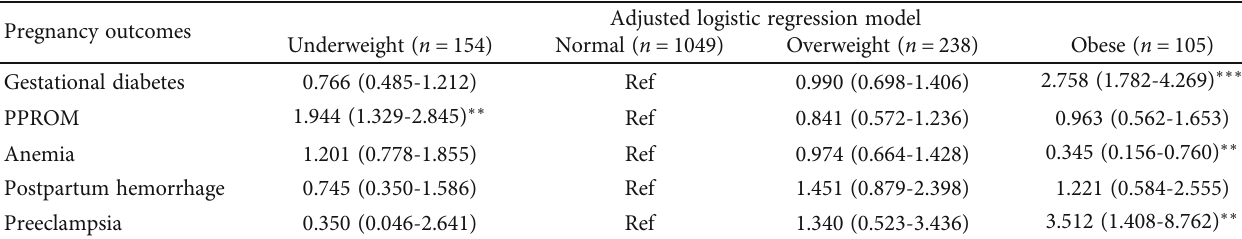
Table 3: The association between prepregnancy BMI and pregnancy outcomes, adjusted logistic regression